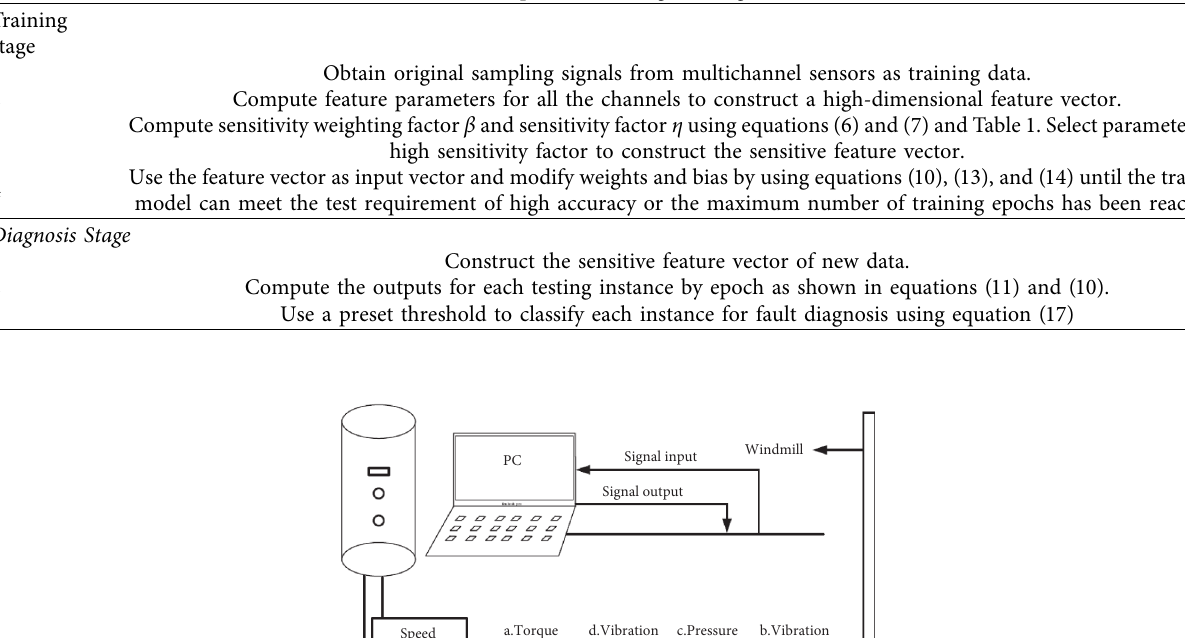
Table 2: Proposed fault diagnosis algorithm.